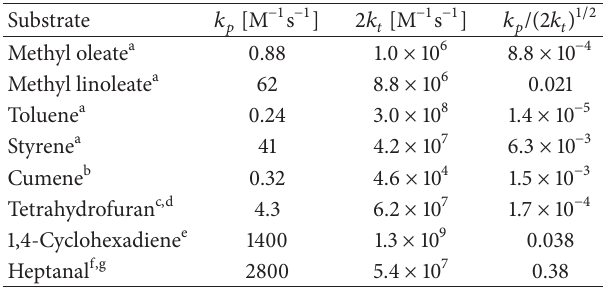
Table 1: Rate constants for the autoxidation of selected organic substrates in PhCl at 303